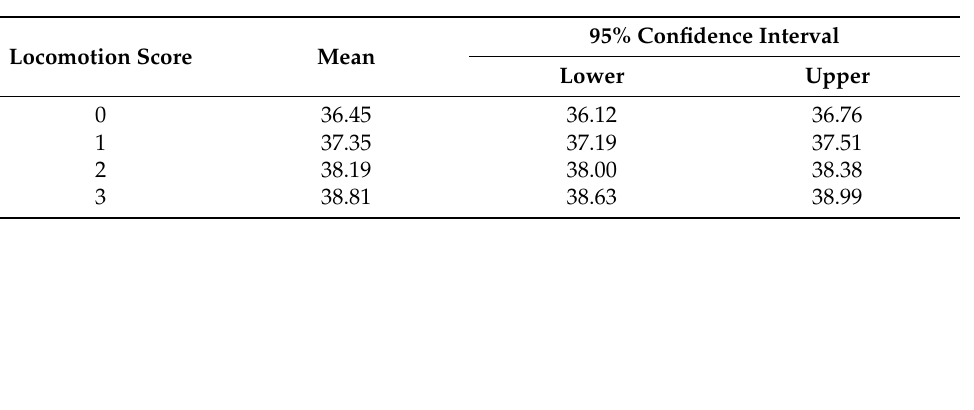
Table 5. The mean temperature (degrees centigrade) from plantar aspects across both feet (all 14 zones) and 95% confidence interval for different locomotion scores (0–3) DairyNZ on three farms in Morogoro ( n =